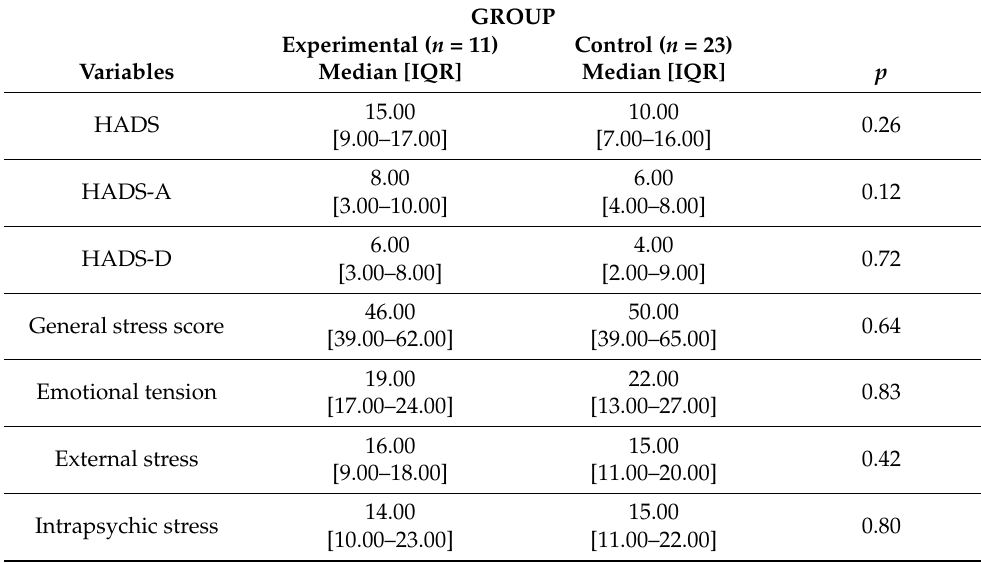
Table 2. Baseline measurement of